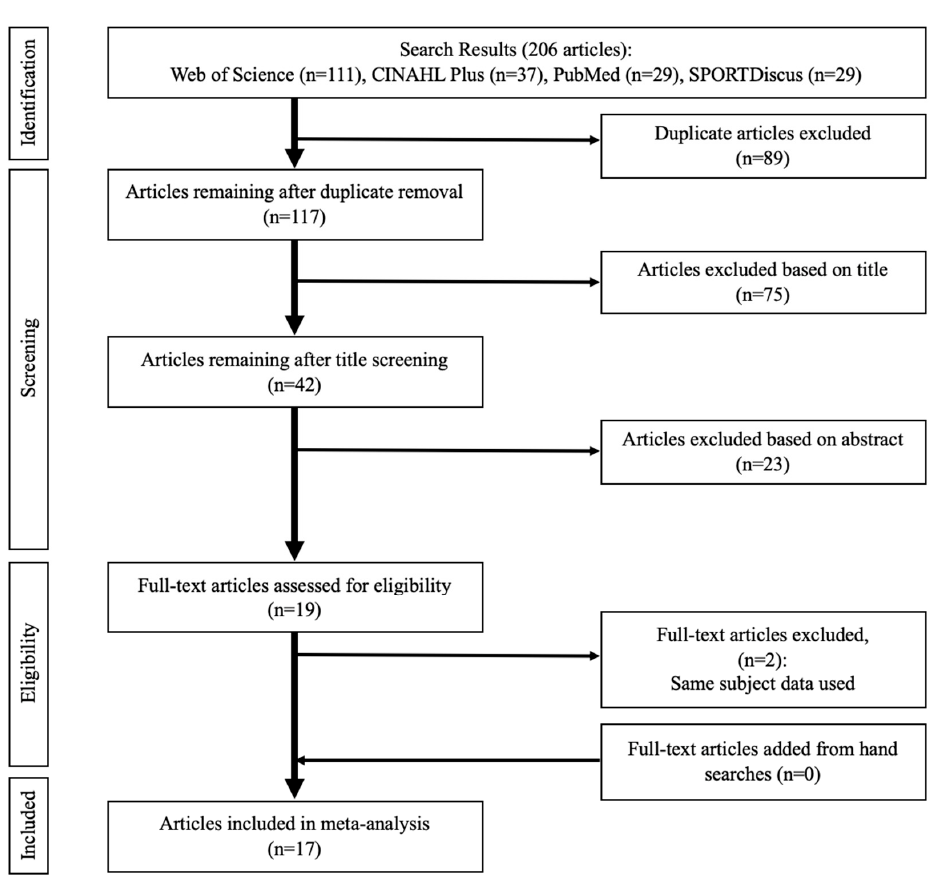
ff erent stages of study screening and